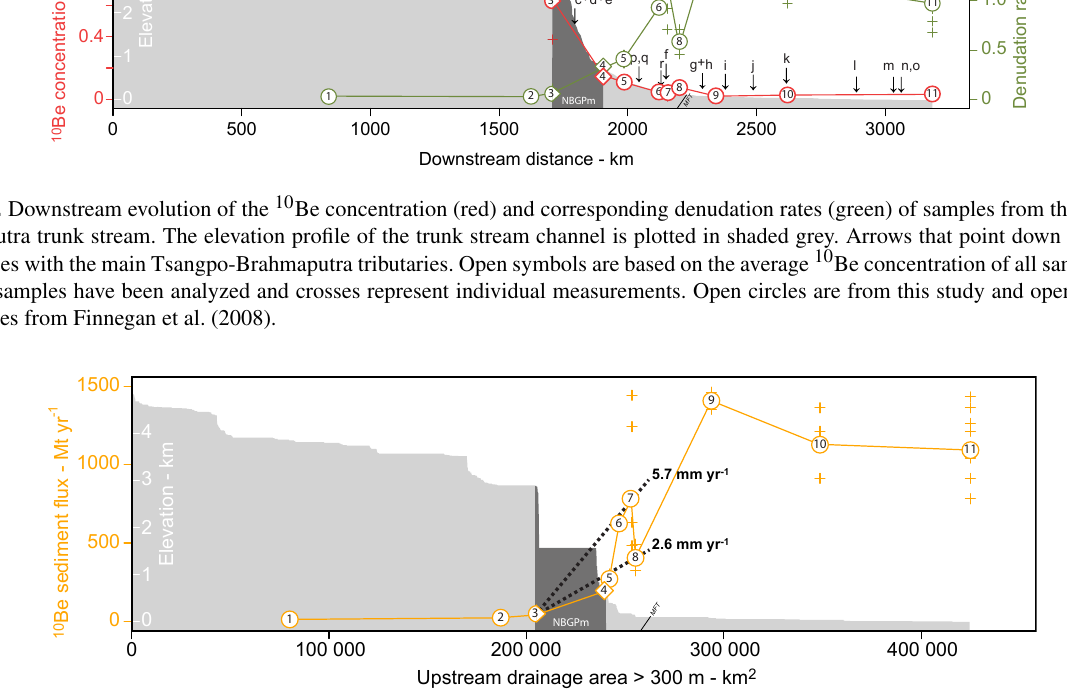
Figure 4. Evolution of the 10 Be-derived sediment flux as a function of the upstream drainage area above 300m of elevation (in order to remove floodplain area storing sediments) from the Tsangpo-Brahmaputra trunk stream along with the channel elevation profile in grey. The average denudation rate over a given reach of the river is given by the slope of the regression between sample points. Open symbols are based on the average 10 Be concentration of all samples when multiple samples have been analyzed and crosses represent individual measurements. Open circles are from this study and open diamonds are samples from Finnegan et al.